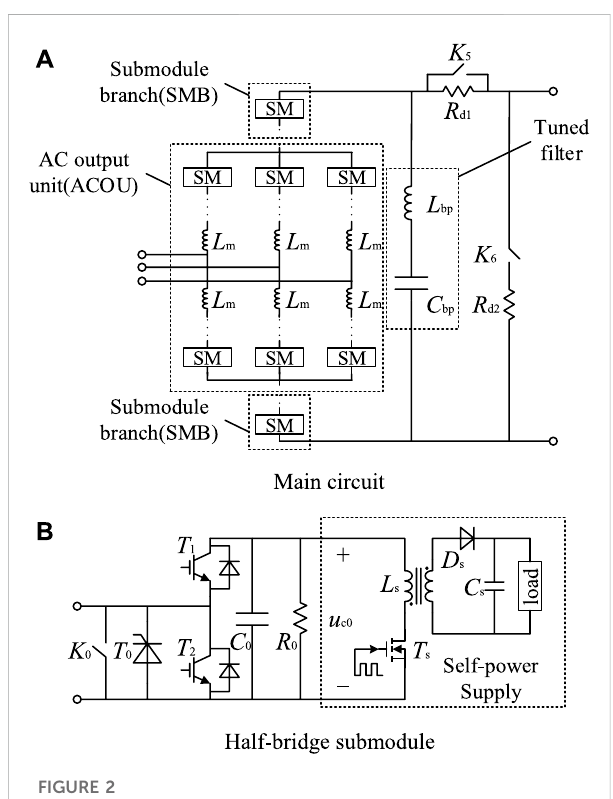
FIGURE 2 Topology of auxiliary converter. (A) Main circuit. (B) Half-bridge